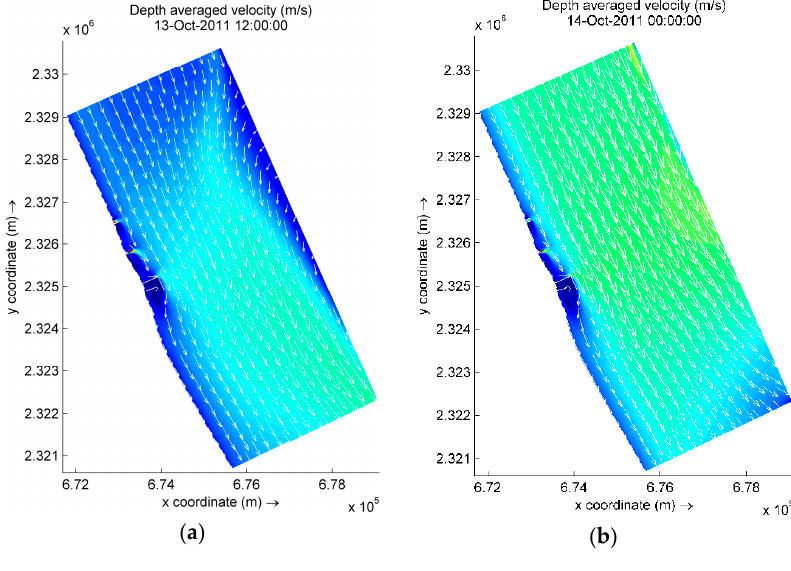
Table 4. Calculated efficiency coefficients for each